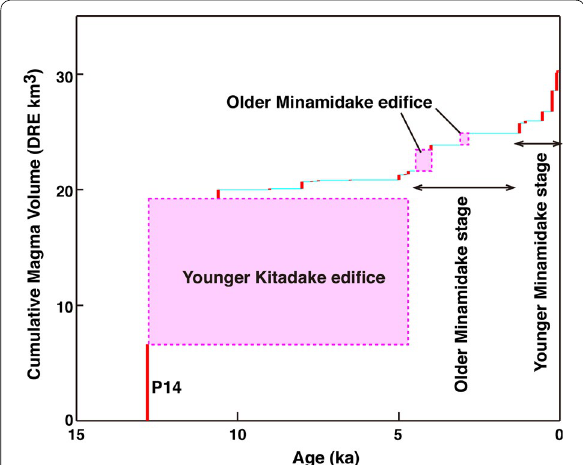
Fig. 3 Cumulative magma volume erupted from Sakurajima Volcano. A red solid line represents an eruption event. A pink square shows the ranges of volume and age for a volcanic edifice which is undivided into separate eruption events. P14 is the Sakurajima-Satsuma tephra, which occurred at the beginning of Younger Kitadake stage after a long repose (Kobayashi et al. 2013). The eruption rate is apparently increasing in the recent Younger Minamidake